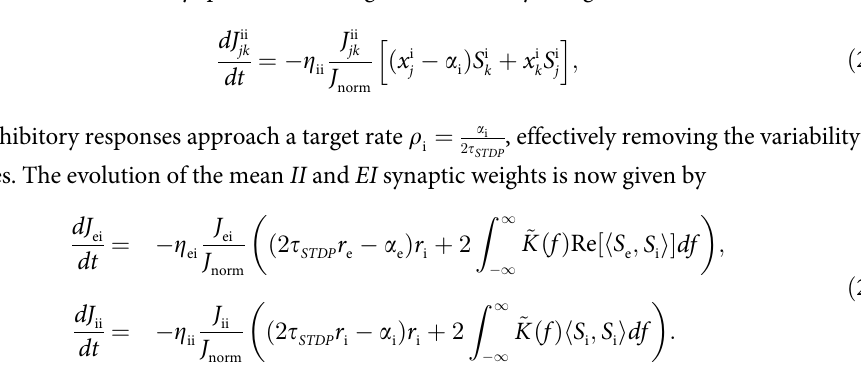
Fig 3. Correlations between synaptic weights and inhibitory rates lead to the formation of a manifold in weight space. A : The rate of change of EI weights as a function of the weights themselves. The contributions of the covariance (blue) is considerably smaller than the contribution of the rate (red), and the theory predicts a stable fixed point. B : Evolution of inhibitory weights showing that different initial weights converge to different fixed points. Also, weights starting at different initial conditions converge to equilibrium at different times for fixed 1/ η ei = 10 5 ms. C : A manifold of fixed points in j � space emerges due to correlations between weights and rates. Solid line represents simulations, dashed line are values obtained from the modified theory (Eqs (23) and (5), and mean–field equation for weights under iSTDP in Table 1). Inset: Final distribution of EI weights for a network with initial weights ¼ (cid:0) 150 (yellow), and j 0 ¼ (cid:0) 50 (blue). Modified theory predicts the manifold of fixed points. D : Same as A , but obtained from simulations. Lines j 0 ei ei represent trajectories from different initial weights (red dots). Inset: Total recurrent input to E neurons, R ¼ w þ w . The mean input deviates from the total input due to emergent correlations between weights r r e ; mean ee e ei i and rates, Cov( J ei , r i ) = R e,total − R e,mean . E : The weights of individual EI synapses corresponding to the same post–synaptic E cell as a function of the equilibrium firing rates of pre–synaptic I neurons. Each color represents a different simulation of the network with different initial EI weight. Equilibrium inhibitory weights and pre–synaptic rates are correlated (Blue: R 2 = 0.952, Red: R 2 = 0.9865, Yellow: R 2 = 0.979). F : Sample trajectories of the j ei − j ii system for a network of N = 10 4 neurons in an asynchronous state. Simulations with different initial weights (dashed lines), converge to a fixed point close to the one predicted by the theory (solid